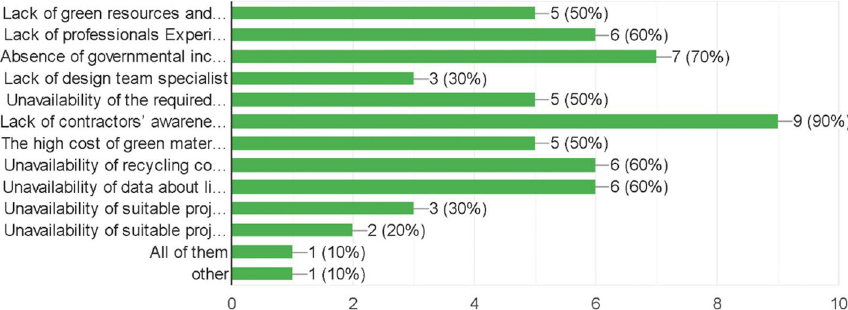
Fig. 7 The Obstacles that are facing project managers in green building projects in Egypt. Ref: